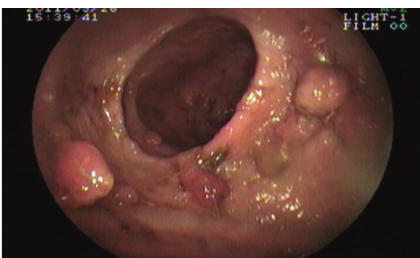
Figure 7: Diffuse polyposis in colon.